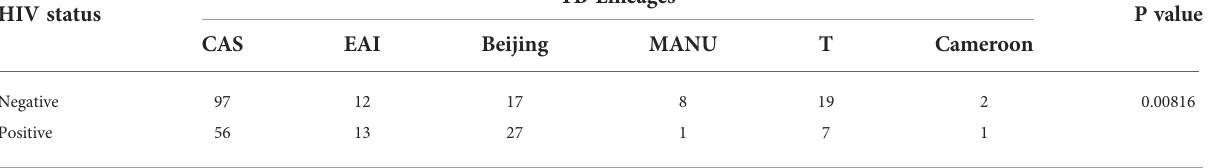
TABLE 3 Distribution of TB lineages in HIV positive and HIV negative population.